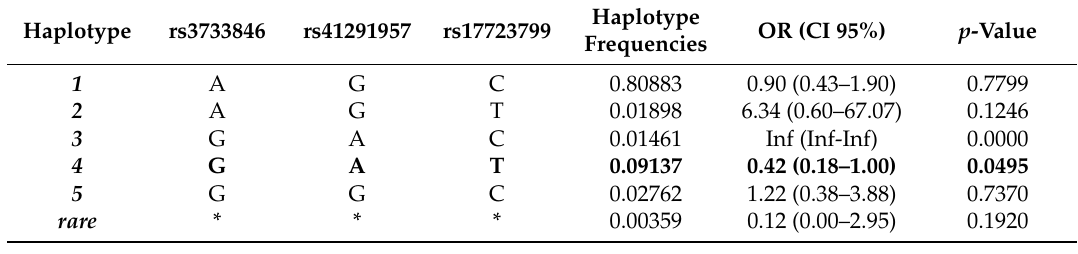
Table 10. Association of haplotypes for analysed MIR143 SNPs in GLP-NHL case and control populations.